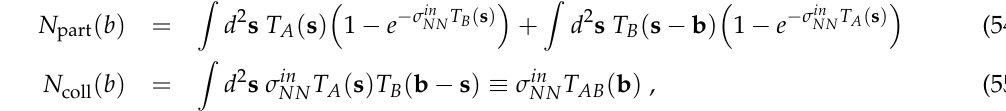
Figure 11. A Glauber Monte-Carlo event (Au + Au at ( left panel) and along the beam axis ( right panel). The nucleons are drawn with diameter Darker disks represent the participants, and lighter disks represent the spectators. Reproduced from Ref.